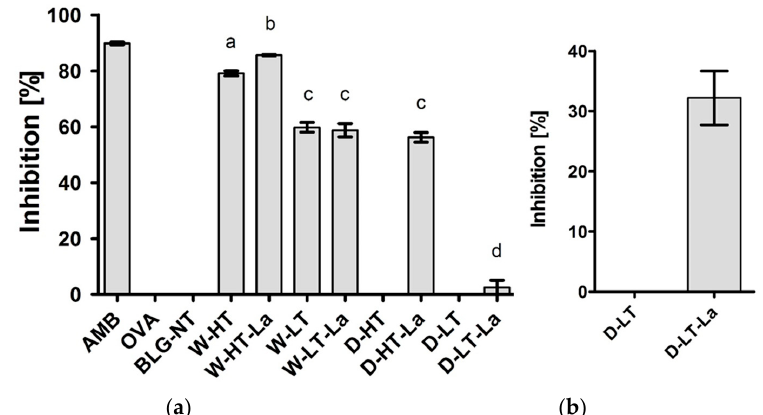
Figure 5. ( a ) Inhibition of sRAGE binding in competition ELISA by BLG heated in wet system (W) and dry system (D) in the absence of lactose or presence of lactose (La) at high or low temperature (HT and LT) for all treatments at a protein concentration 25 µ g / mL. AMB: amyloid- β (positive control), OVA: ovalbumin (negative control). ( b ) Results of inhibition sRAGE ELISA for D-BLG-LT and D-LT-LA at a protein concentration 100 µ g / mL. Error bars represent standard deviation of technical triplicates. Letters indicate significant di ff erences between the BLG groups. p -values < 0.05 are considered statistically significant, as analyzed with one-way ANOVA with Tukey post hoc comparison test